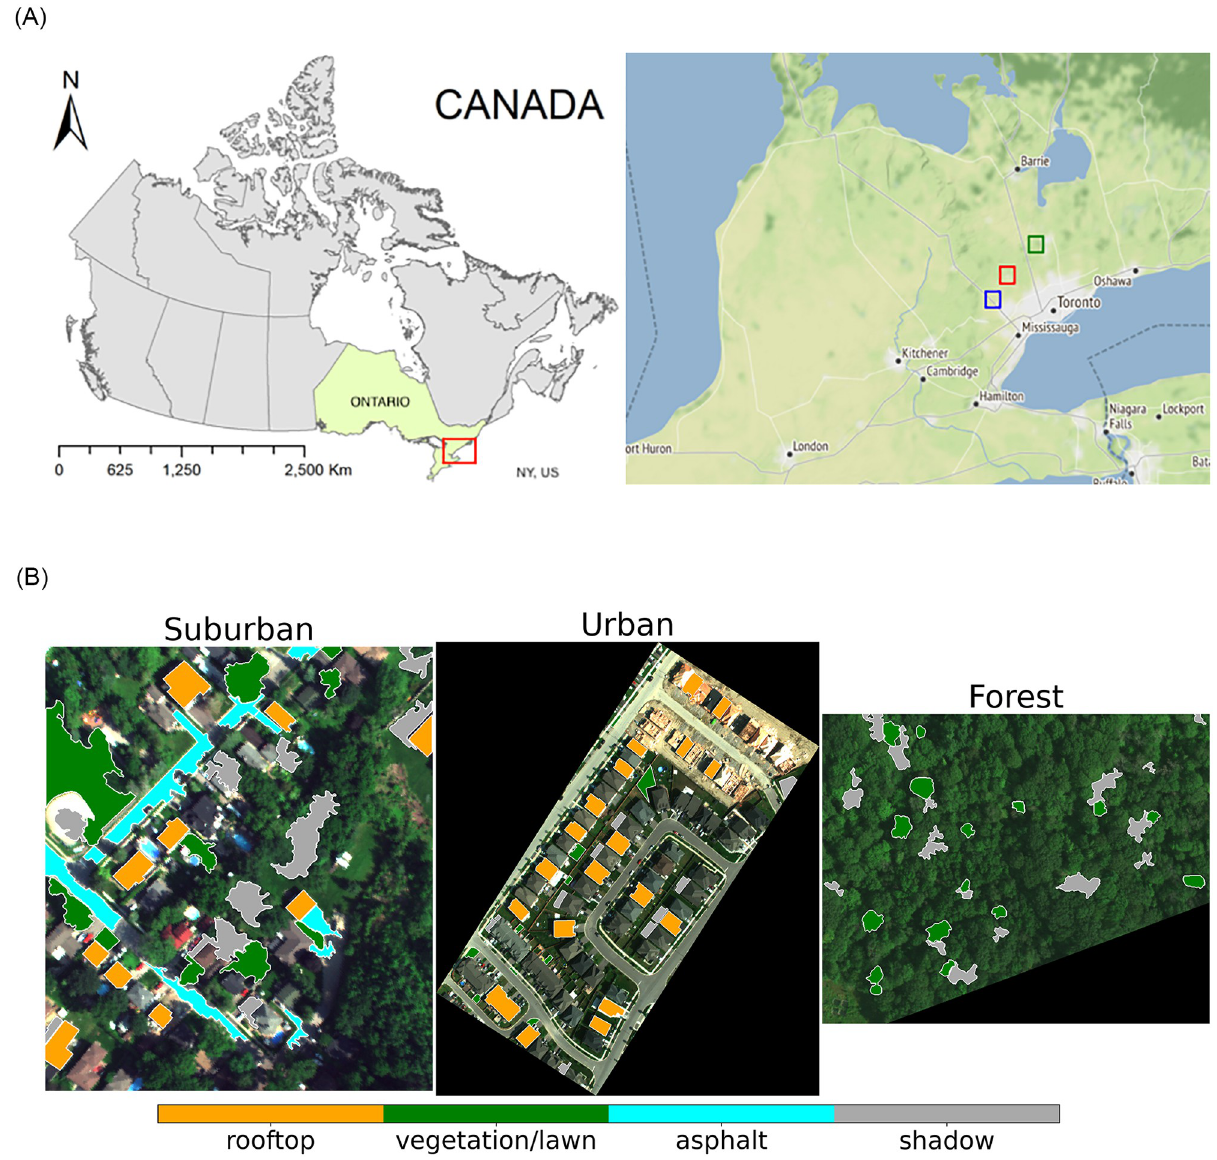
Fig 1. Hyperspectral datasets were collected by the Remote Sensing and Spatial Ecosystem Modeling (RSSEM) Laboratory Department of Geography, Geomatics and Environment, University of Toronto using an airborne sensor over an area around Toronto, Ontario, Canada. Top left : Study area; Top right : the red, blue, and green areas represent Suburban, Urban, and Forest images, respectively (the rectangles are not to scale). Bottom row : shows the three datasets in pseudo color (RGB images). This visualization was constructed using the 670 nm (red), 540 nm (green), and 470 nm (blue) bands from original HSI data. The yellow, green, blue, and gray polygons overlaid on the hyperspectral images are the areas for which ground-truth pixel labels